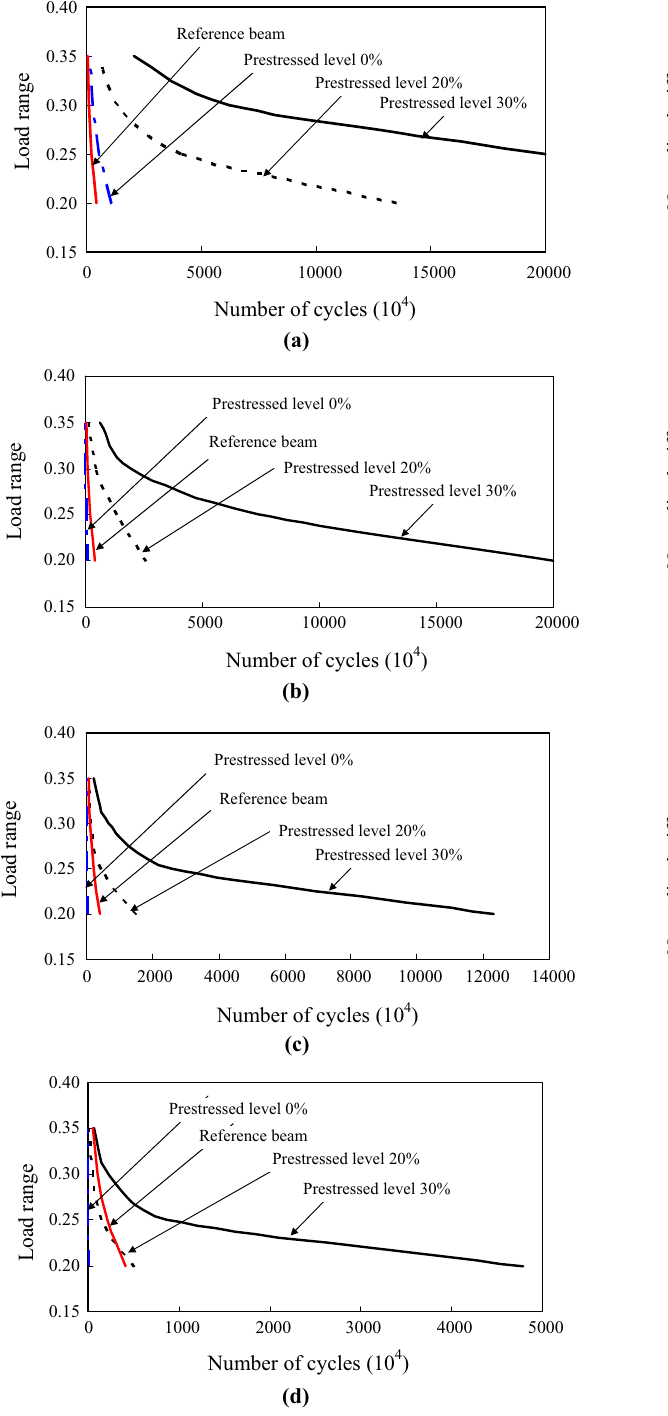
Fig. 6 Load range versus fatigue life: a 5% corrosion degree, b 10% corrosion degree, c 15% corrosion degree, and d 20% corrosion degree.